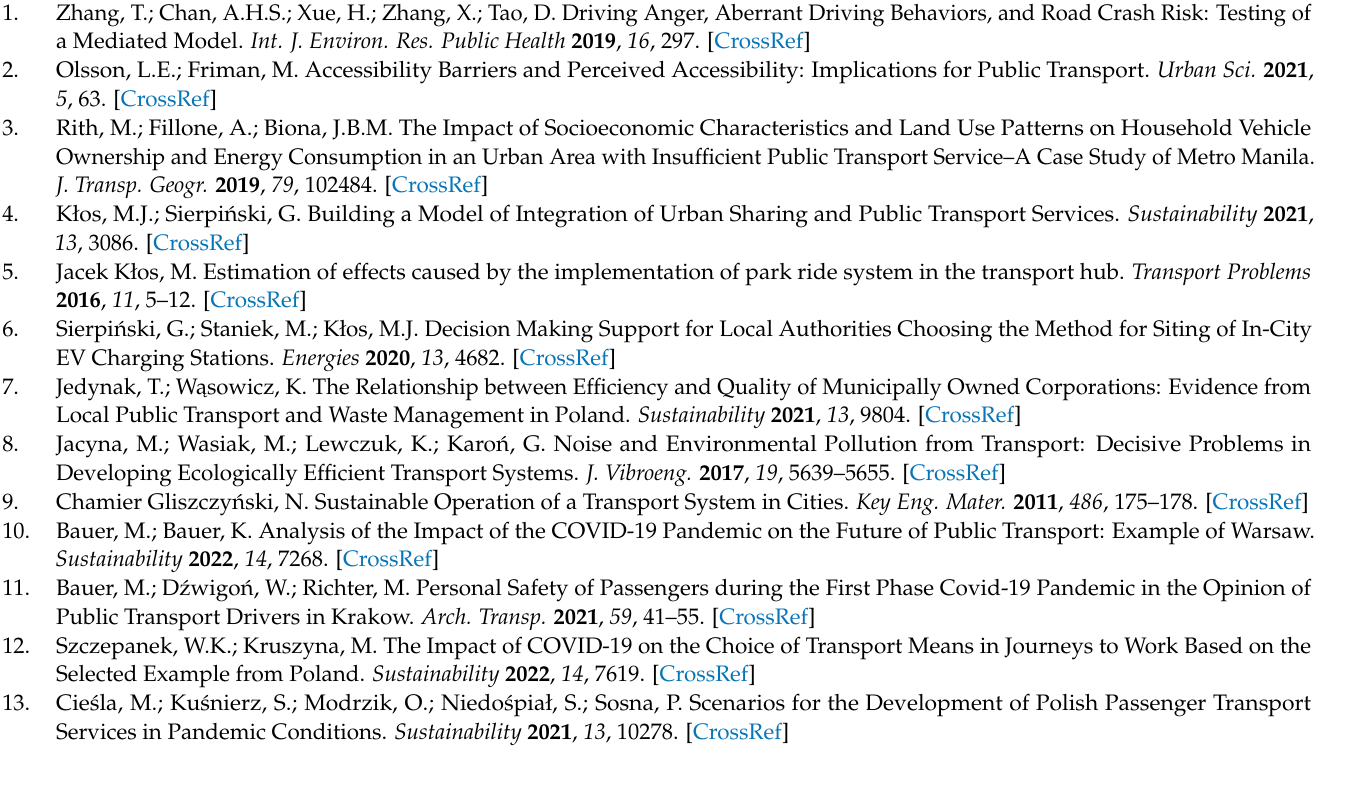
Figure A1. Spatial temporal analysis of IQR R avg peak periods and types of traffic